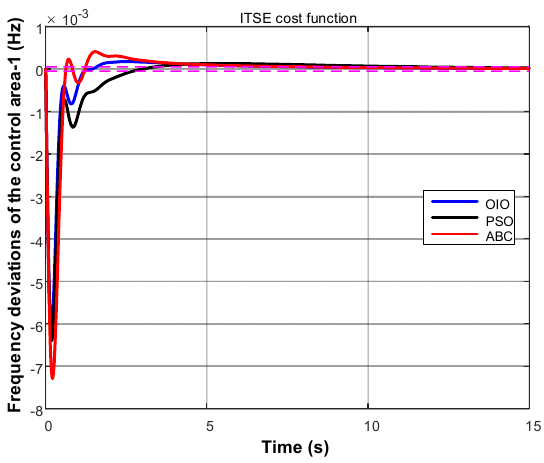
Figure 5. Change in frequency of area ‐ 1 for ISE.